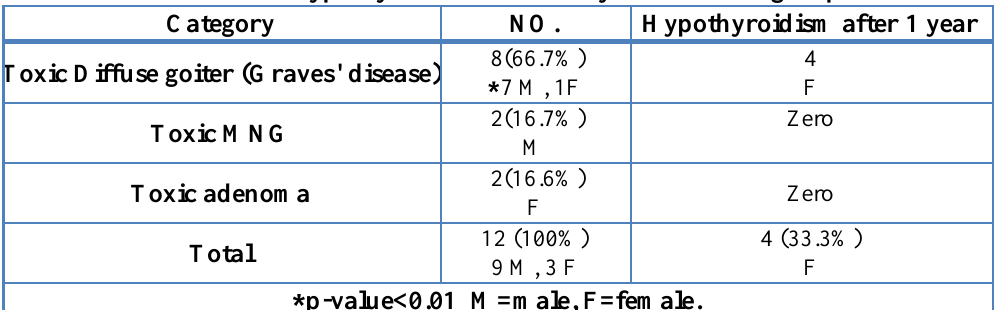
Table 3: The evidence of hypothyroidism after one year in the 2 nd group.